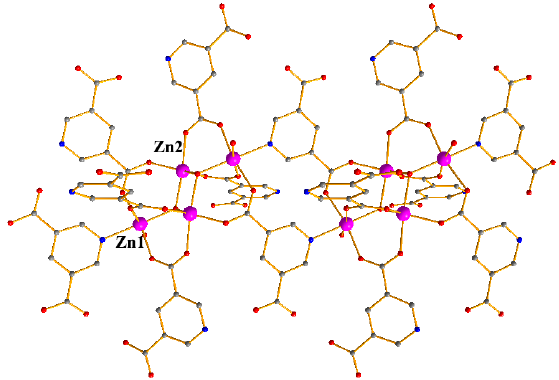
Figure 1. The coordination of Zn ions in the compound.